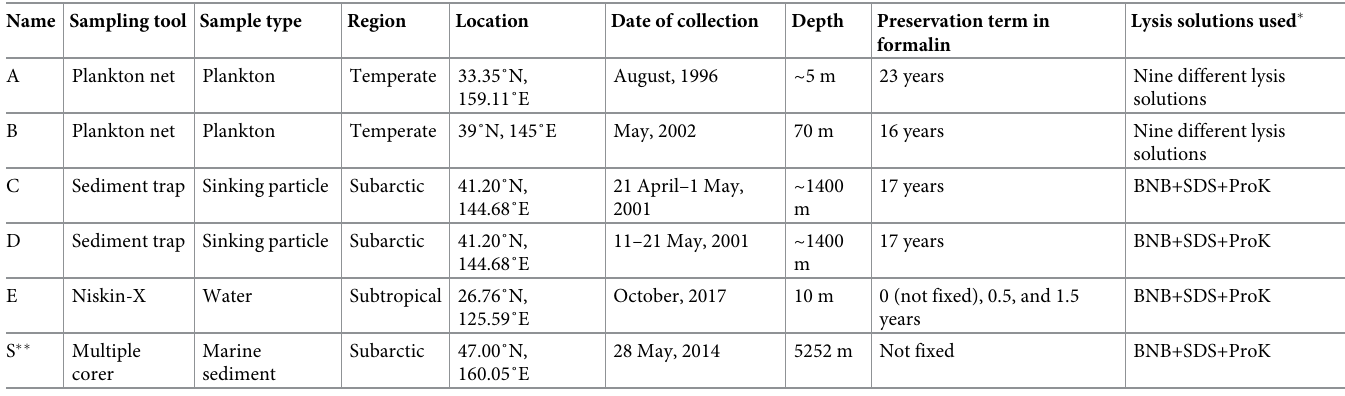
Table 1. Description of samples used in this